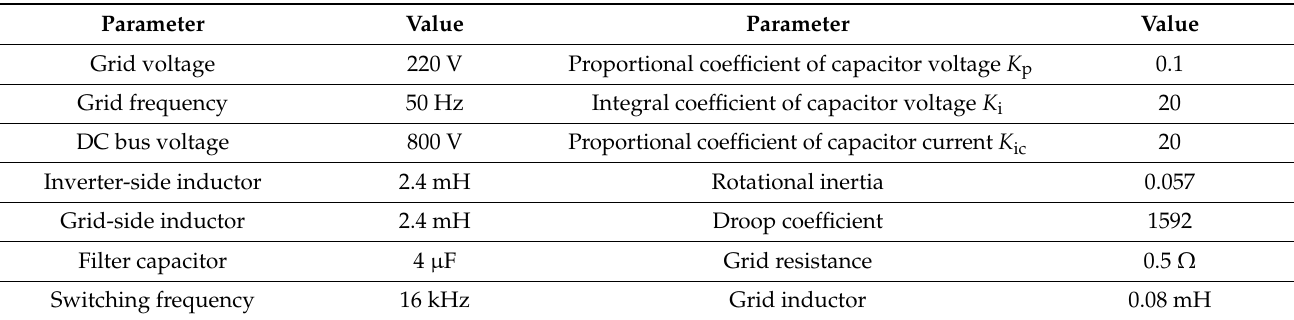
Table 1. Parameters of an LCL-type three-phase